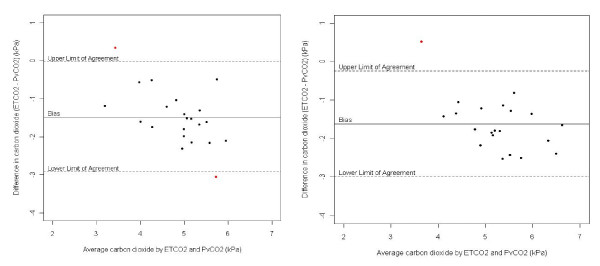
Bland-Altman plots.